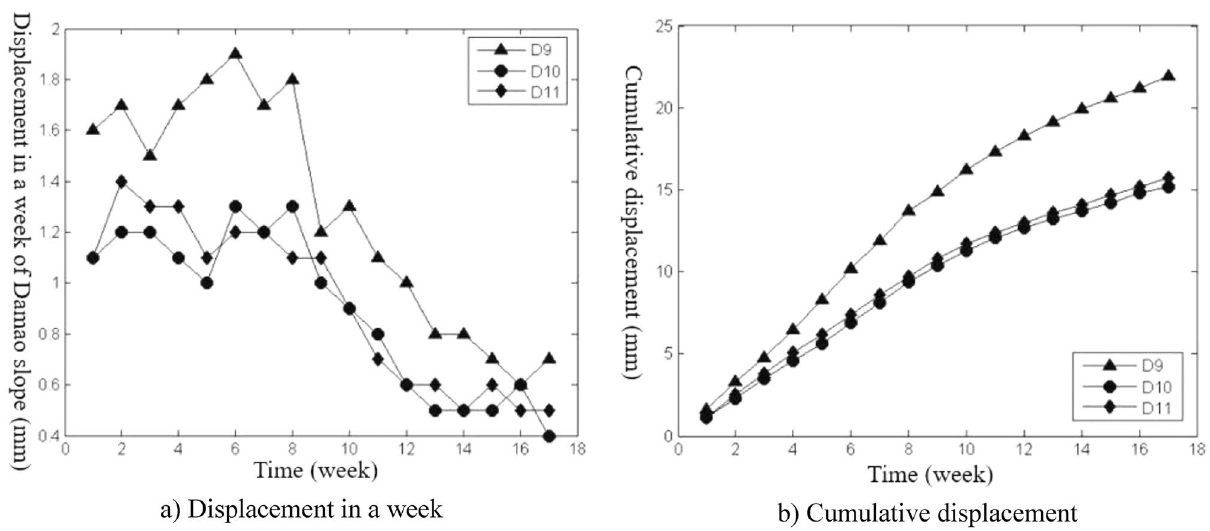
Figure 7. Displacement curves of the first-level platform monitoring points from July 26 to November